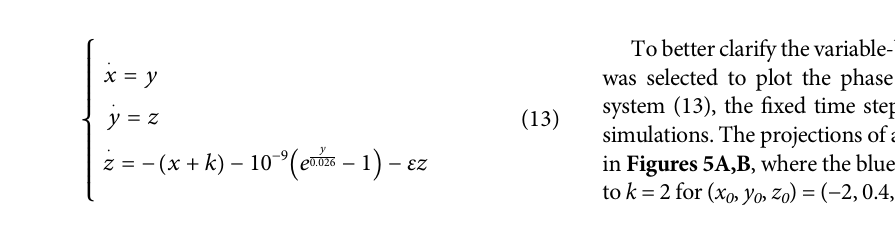
Frontiers in Physics |